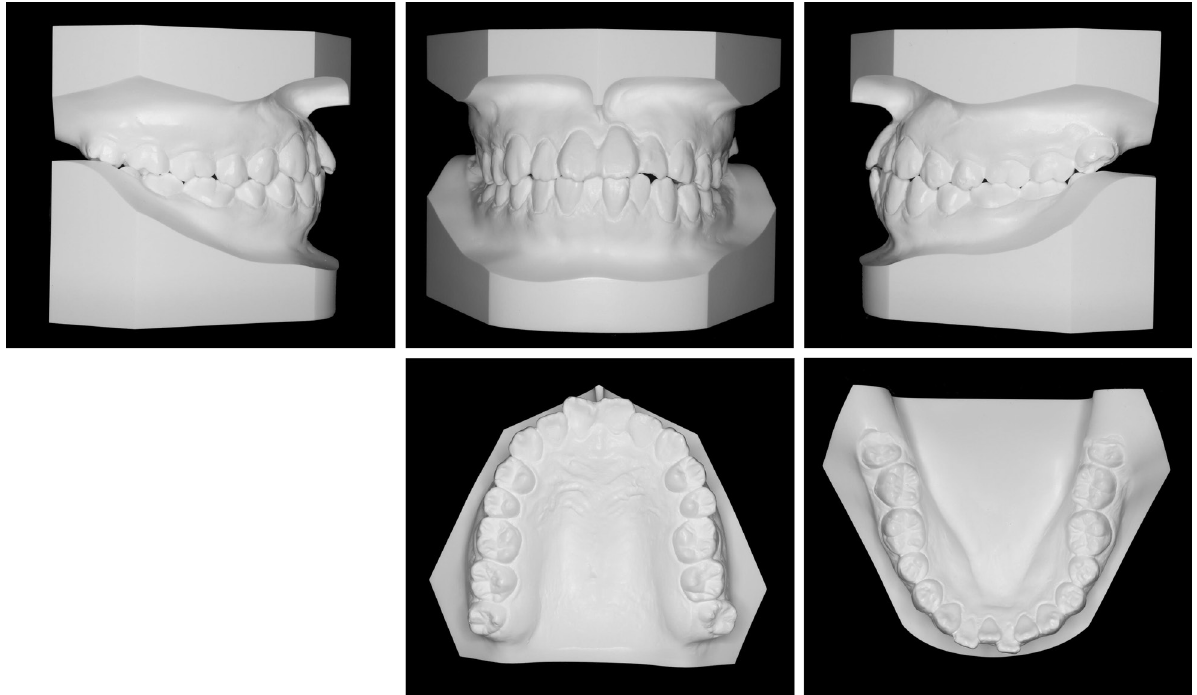
Figure 2. Pretreatment dental